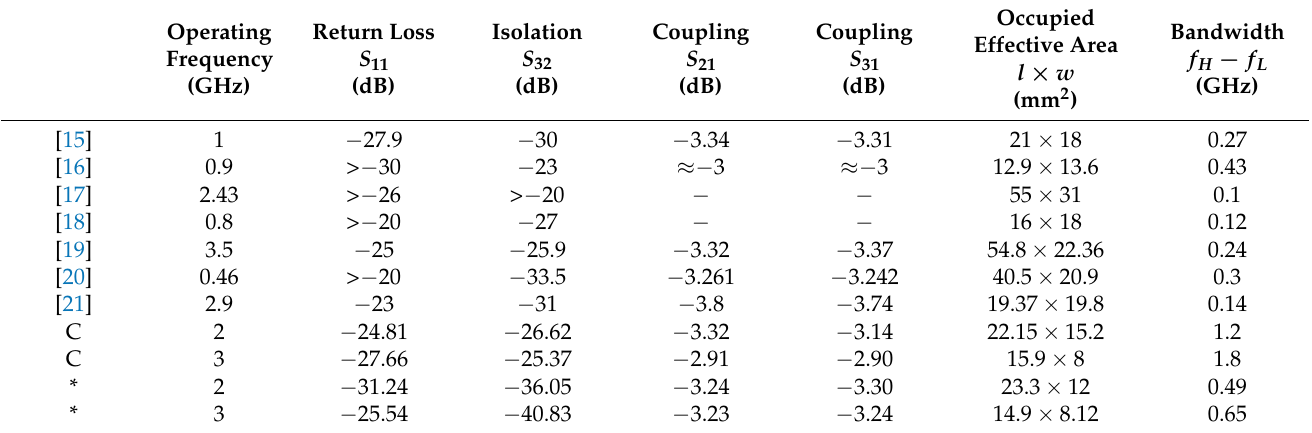
Figure 16. Measured S–parameter results ( S 22 , S 33 ) of the proposed WPD circuits. Table 5. Comparison of fabricated WPDs’ results with other major similar